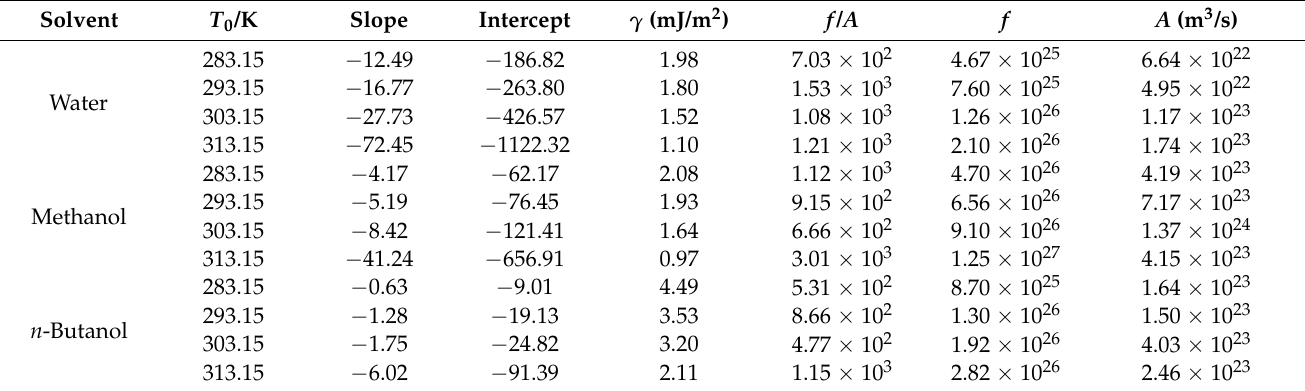
Table 5. Value of nucleation kinetic parameters calculated by Equation